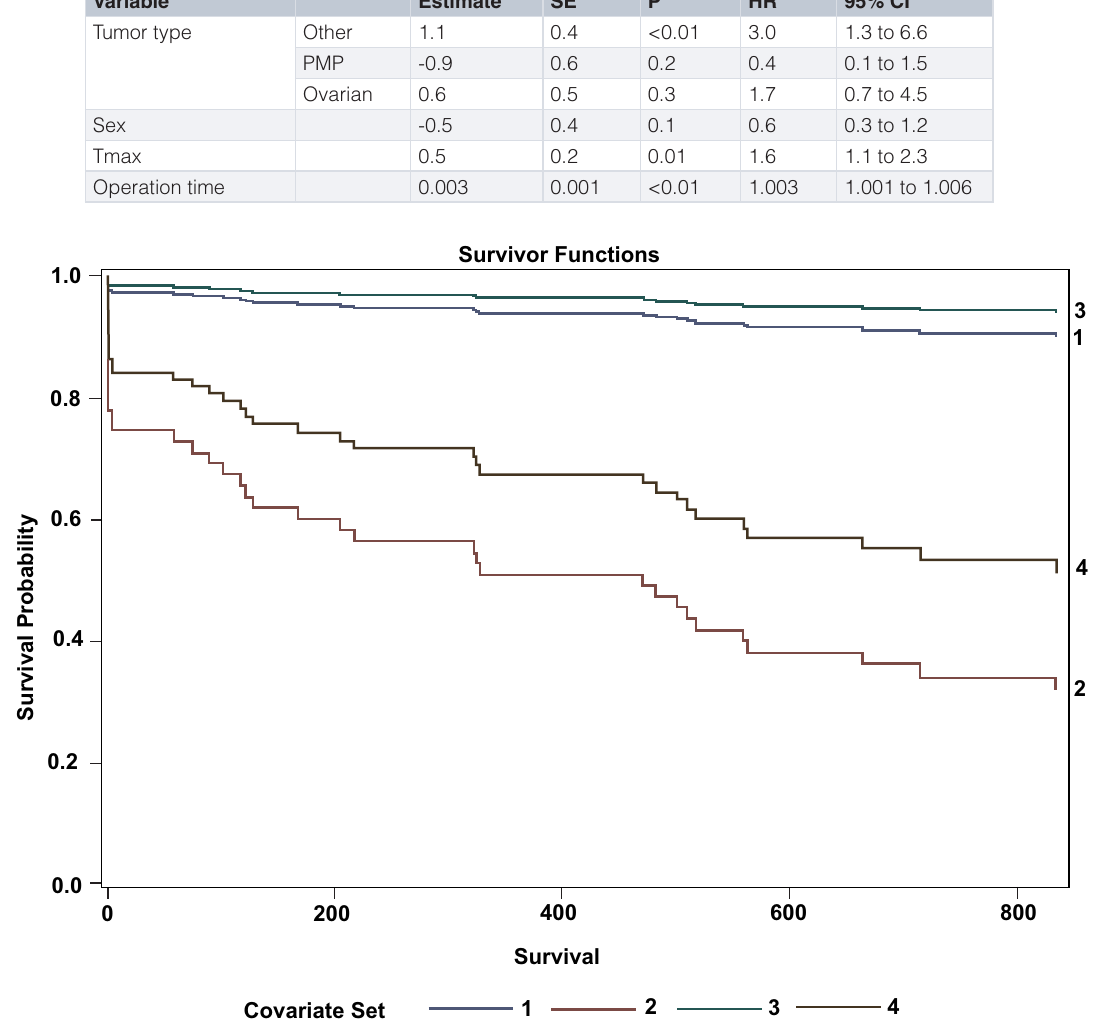
Figure 13. Estimated survival (days) curves for patients with PC from colorectal origin. 1: males, 37°C; 2: males, 42°C; 3: females, 37°C; 4: females, 42°C. All at 579 minutes operation time (mean).